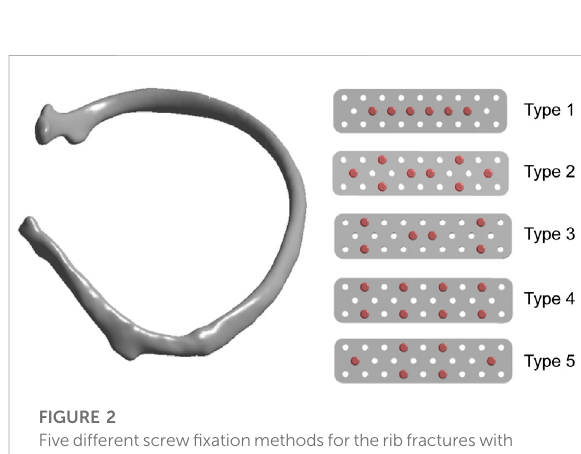
FIGURE 2 Fivedifferentscrew fi xationmethodsfortheribfractureswith absorbable bone